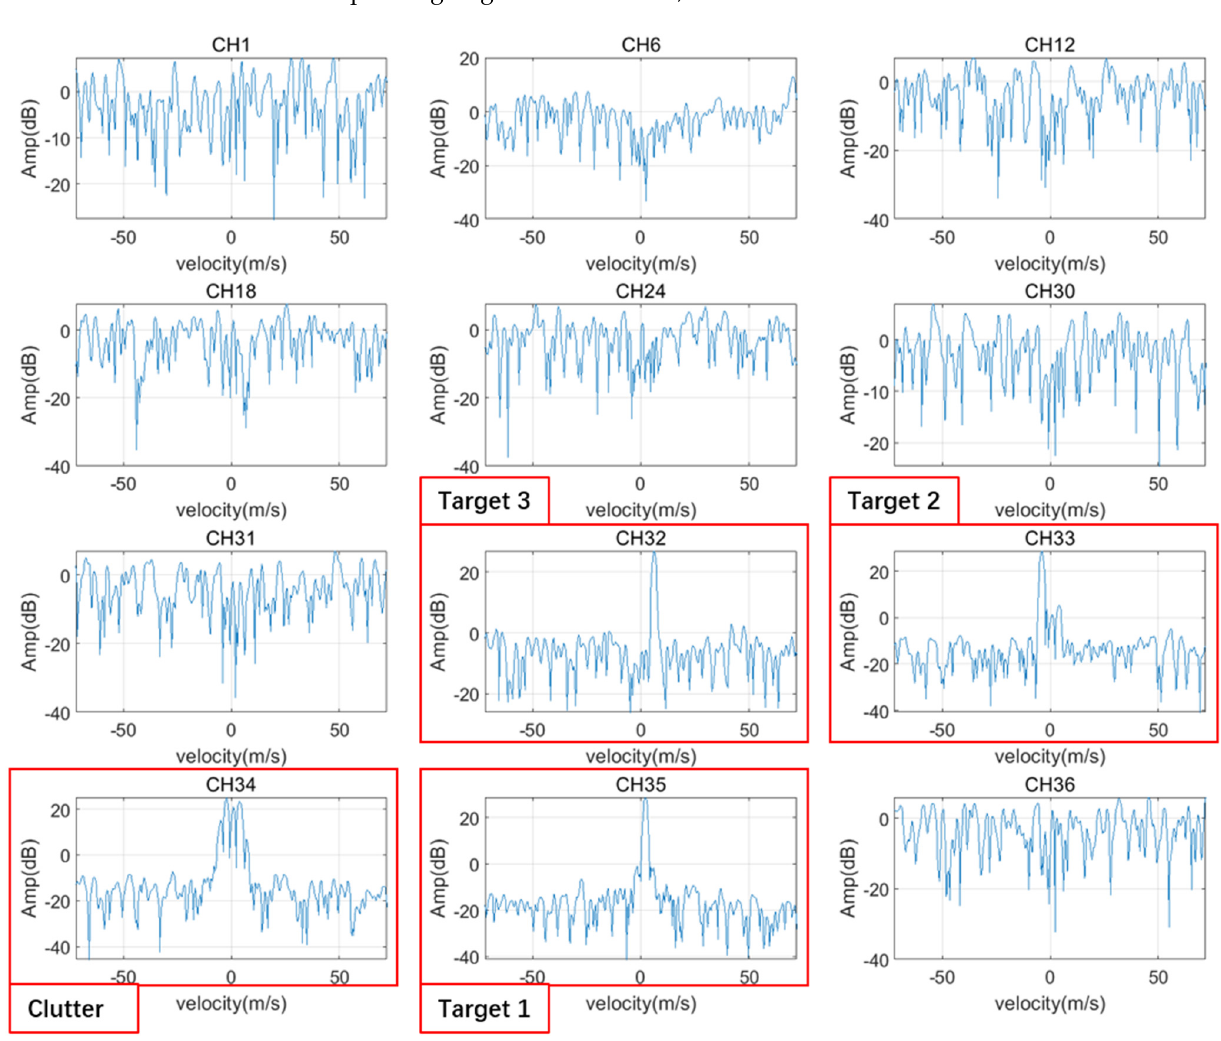
Figure 6. The st − MIMO − ICA output of the mixed signal, where the three targets were separated and were located in Channels 32, 33, and 35; Channel 34 was the ground clutter combination, and the other channels contained noise signals.